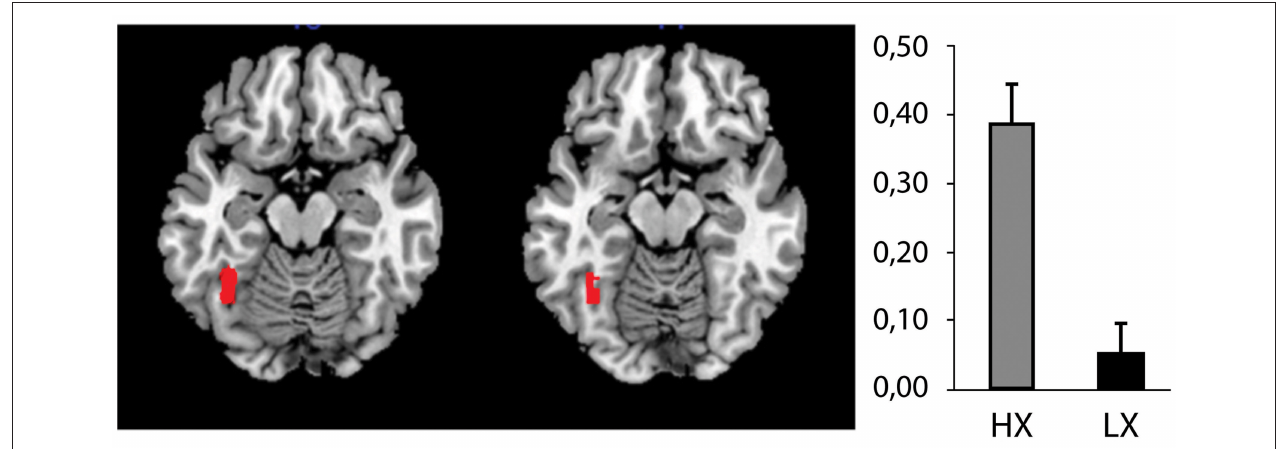
FIGURE 6 | The effect of xenophobic attitudes on brain activation by ERC FACES. The ERC FACES photographs elicited a higher response among the high xenophobia (HX) than among the low xenophobia (LX) subjects (96 voxels, T = 5.7, FWE p = 0.002, mapped on transversal slices of an anatomical template: MNI z = − 16, − 14). The figure on the right shows the parameter estimates ( β values) representing the percentage of blood oxygen level-dependent (BOLD) signal differences between the ERC FACES and the control condition for this fusiform gyrus region.